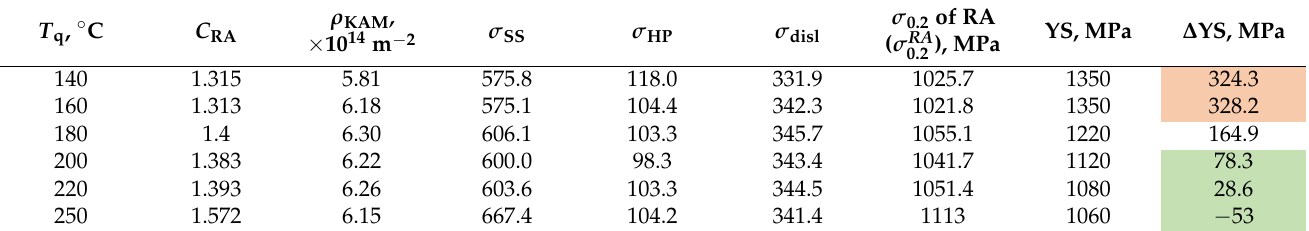
Table 3. Effect of quenching temperature on the contributions of different strengthening mechanisms to the yield strength.